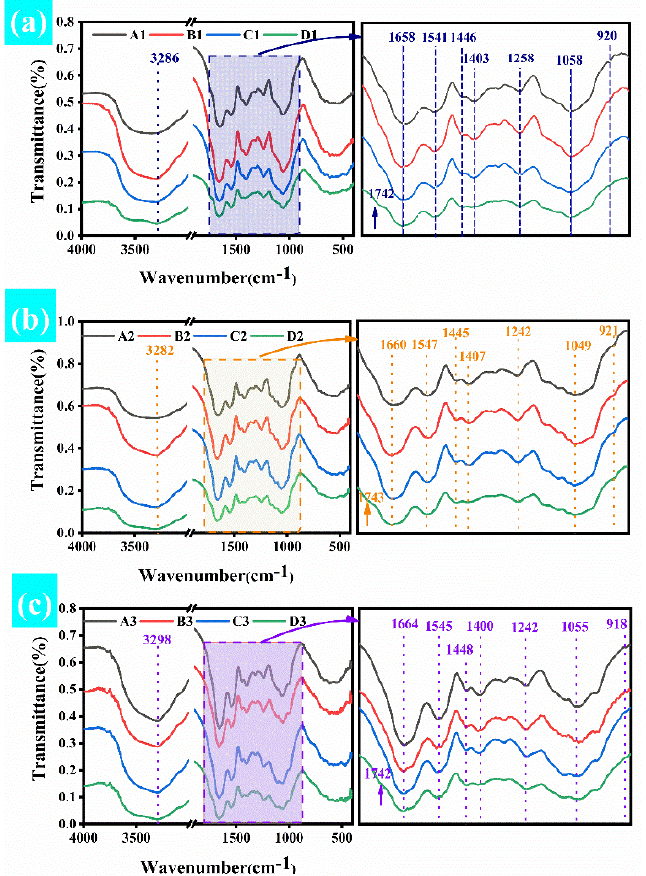
Figure 2. FTIR spectra of ( a ) A1 ‐ pure HPMP, B1 ‐ SDS/HPMP, C1 ‐ SDS/nSiO 2 /HPMP, and D1 ‐ HPMP adhesives. ( b ) A2 ‐ pure SBMP, B2 ‐ SDS/SBMP, C2 ‐ SDS/nSiO 2 /SBMP, and D2 ‐ SBMP adhesives. ( c ) A3 ‐ pure CSMP, B3 ‐ SDS/CSMP, C3 ‐ SDS/nSiO 2 /CSMP, and D3 ‐ CSMP adhesives.